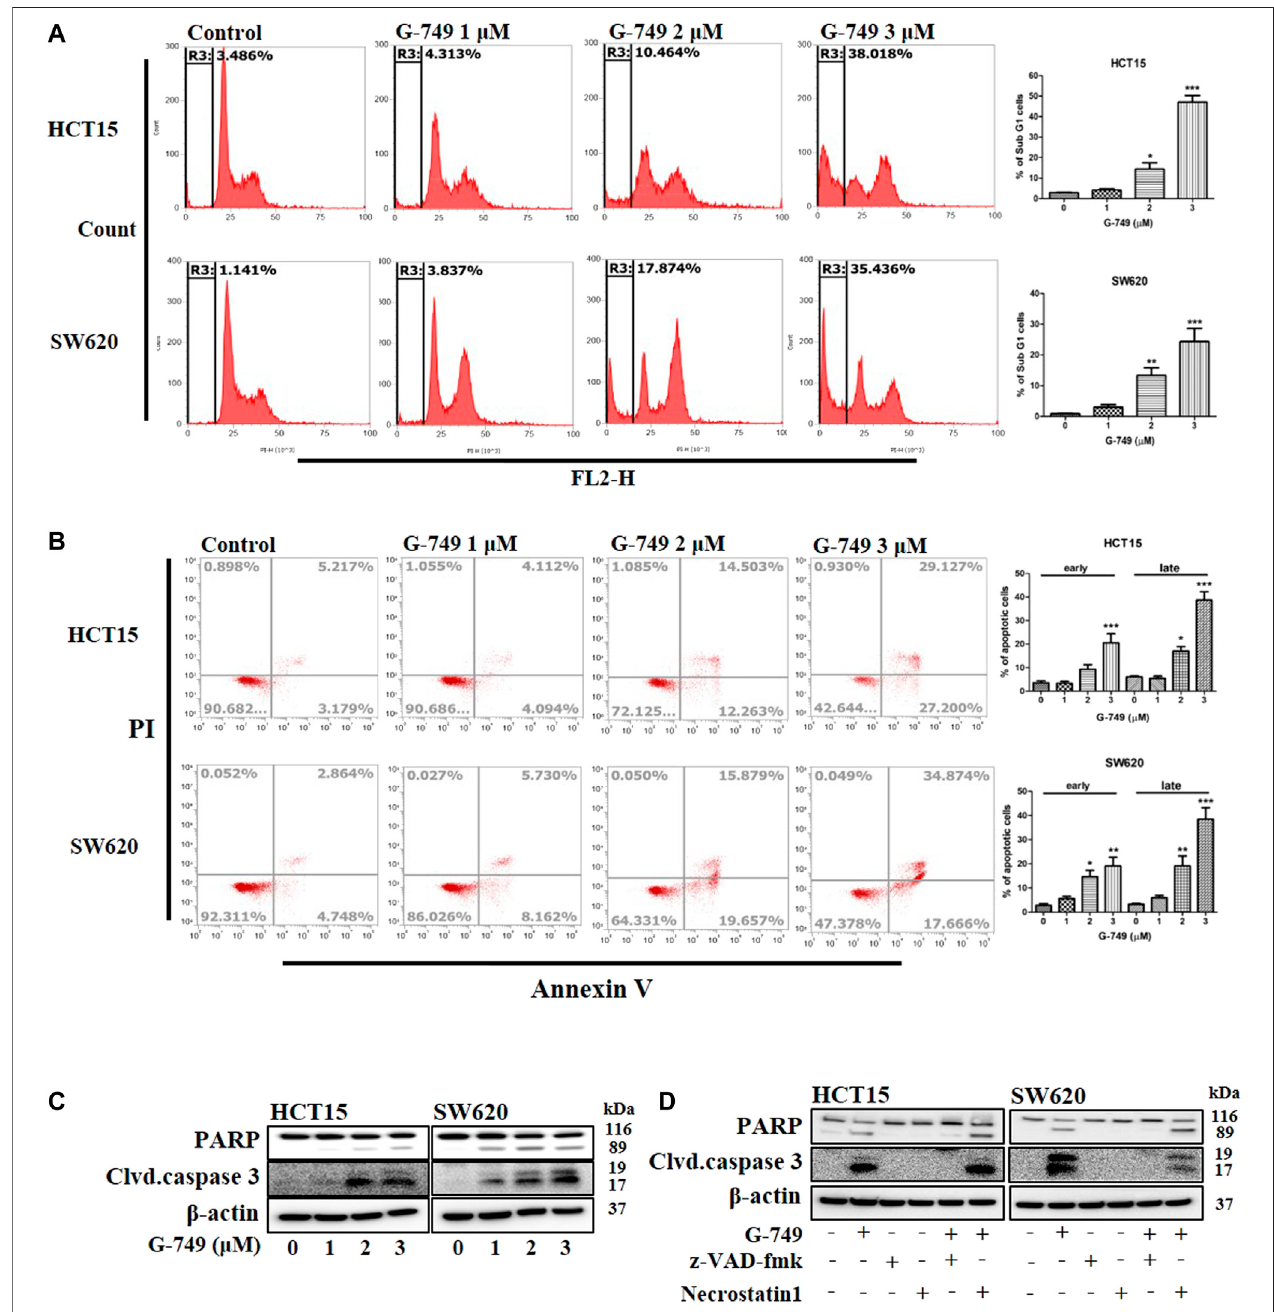
FIGURE 4 | G-749 induces apoptosis in colon cancer cell lines. (A) HCT15 and SW620 cells were treated with the indicated concentration of G-749 for 36 h and then stained with propidium iodide. The SubG1 population was analyzed by fl ow cytometry. (B) Cells were treated with the indicated concentration of G-749 for 36 h. Apoptotic cells were stained with propidium iodide/Annexin V and then analyzed by fl ow cytometry. (C) Cells were treated with G-749 for 36 h. The cell lysates were subjectedtoelectrophoresisandanalyzedbywesternblotwithantibodiesagainstPARPandcleavedcaspase3. β -actinwasusedasaloadingcontrol. (D) HCT15 and SW620 cells were co-incubated with G-749 (3 μ M), z-VAD-fmk (50 μ M), and Necrostatin 1 (30 μ M) for 36 h and analyzed by western blot with antibodies against PARP, cleaved caspase 3 and β -actin. Data are presented as means ± standard deviation (SD). Data were analyzed via one-way ANOVA with Tukey ’ s multiple comparison post-hoc analysis; **** p < 0.0001, *** p < 0.001, ** p < 0.01, * p < 0.05.